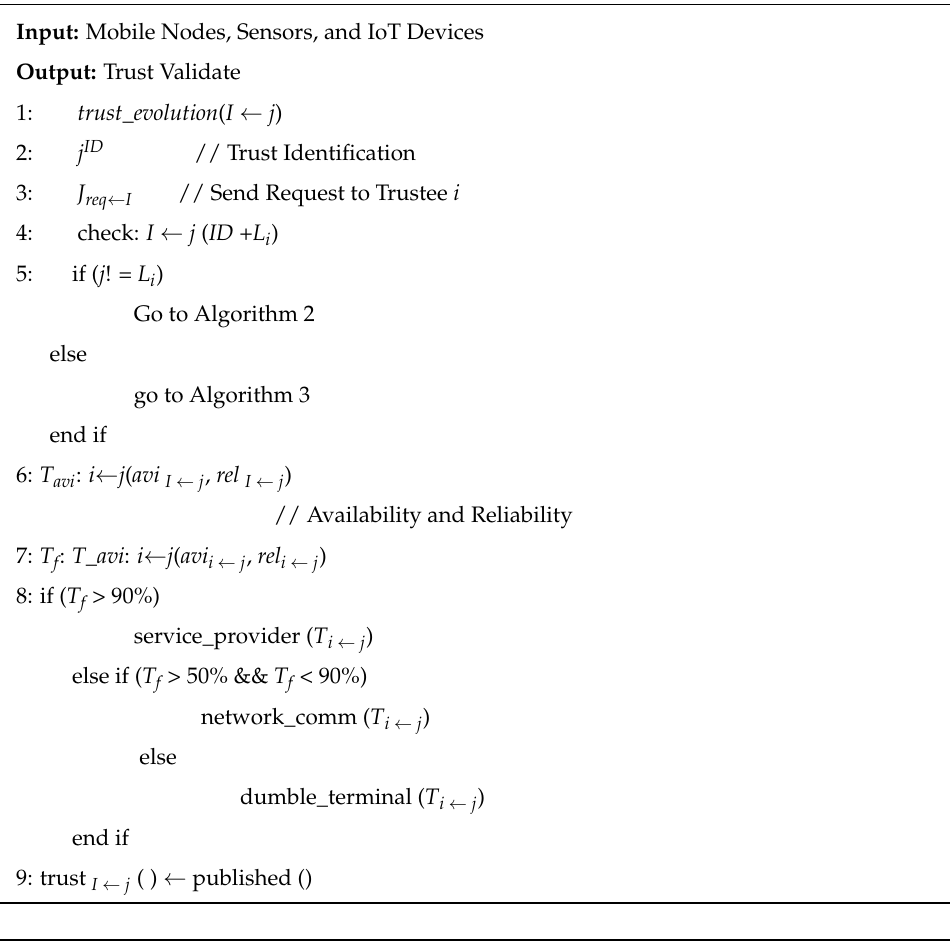
Algorithm 1. QoS Trust Evaluation and Development.